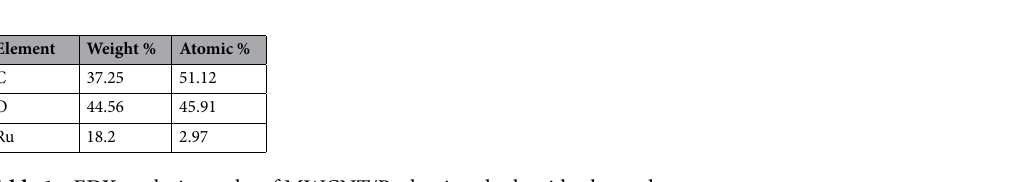
Table 1. EDX analysis results of MWCNT/Ruthenium hydroxide electrodes.